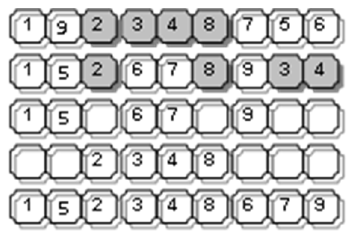
Figure 7. The OX procedure.